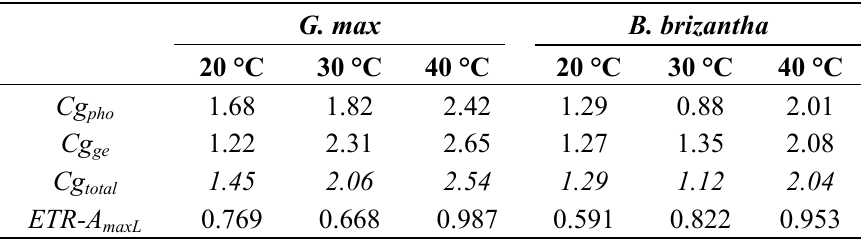
Table 7. Global connectance values of all physiological network ( Cg ), of the photochemical total network ( Cg ) and of the gas exchange network ( Cg ), and the relation between the pho ge photochemical module and the gas exchange module of the network, represented by the ETR- A ratio observed in G. max and in B. brizantha under different temperatures. maxL G.